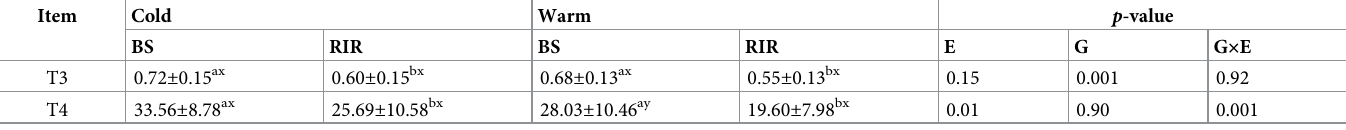
Table 1. Serum thyroid hormone concentrations in two chicken breeds in cold and warm environments at 39 weeks (n = 20, Mean ± SD). Item Cold Warm p -value BS RIR BS RIR E G G×E T3 0.72±0.15 ax 0.60±0.15 bx 0.68±0.13 ax 0.55±0.13 bx 0.15 0.001 0.92 T4 33.56±8.78 ax 25.69±10.58 bx 28.03±10.46 ay 19.60±7.98 bx 0.01 0.90 0.001 a, b Different superscript letters indicate significant difference between breeds under the same environment ( p < 0.05). x, y Different superscript letters indicate significant difference between environments within the same breed ( p <